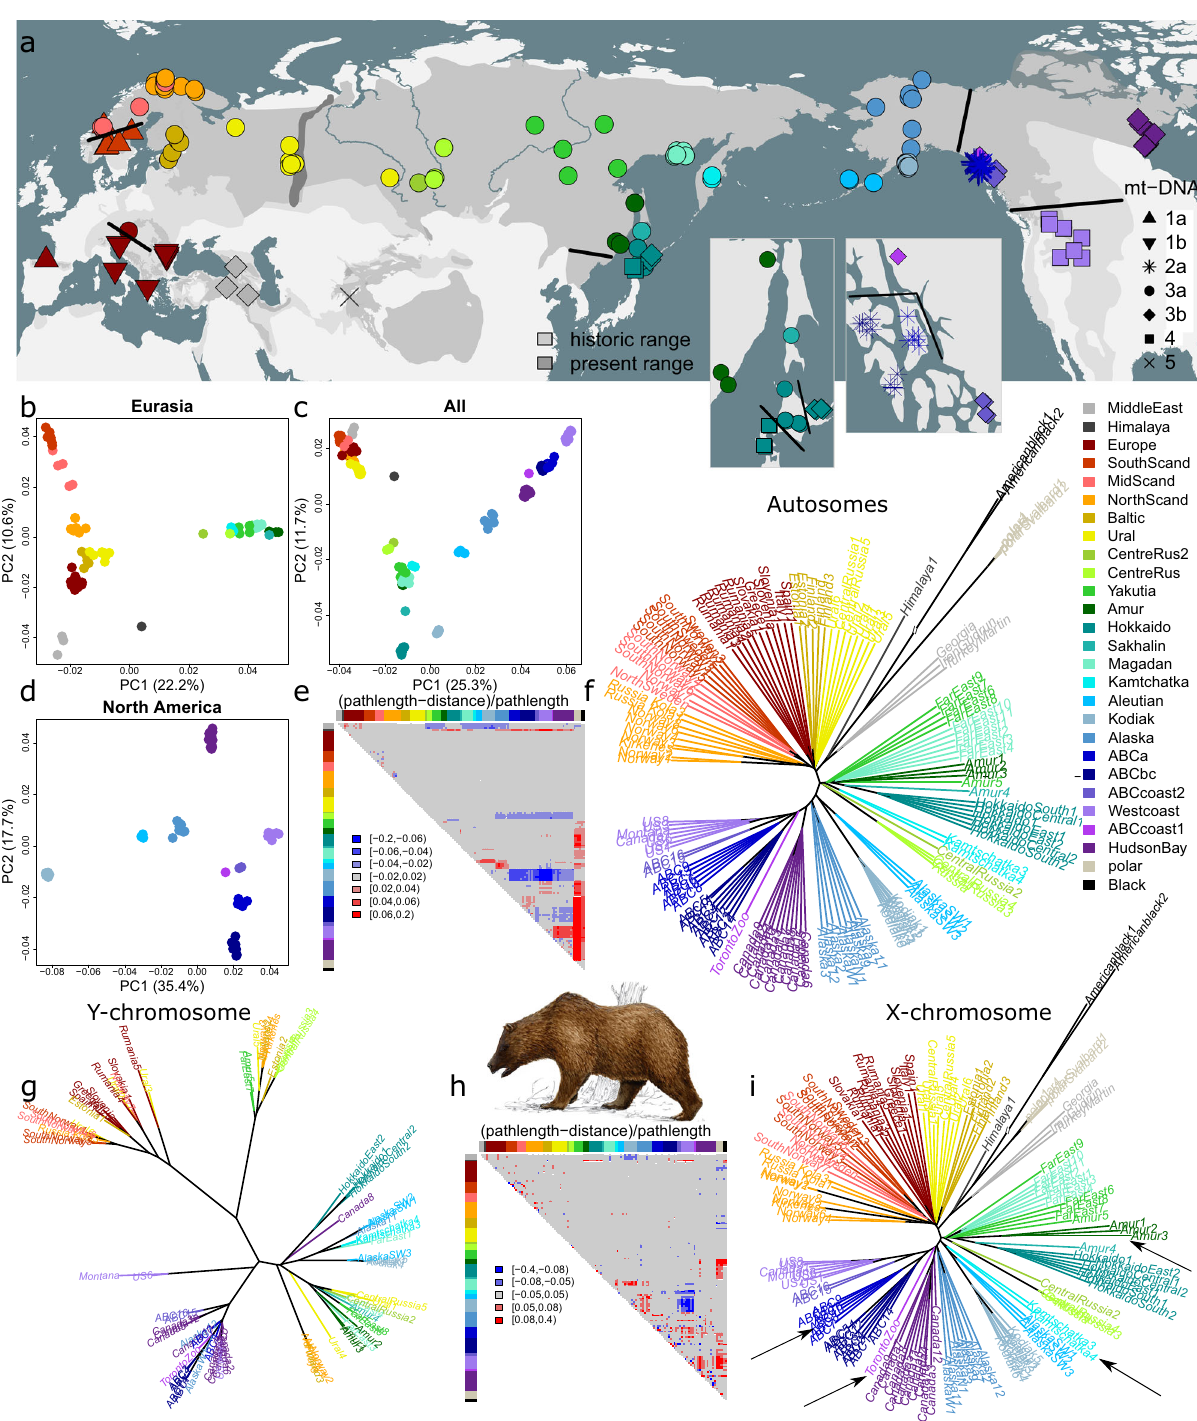
Fig. 1 Brown bear genetic structure: unlike single-locus (mtDNA and Y chromosome) clustering, multi-locus (autosomes and X chromosomes) clustering is largely explained by present-day population connectivity, except for a genomic discontinuity in western Siberia. a Sample distribution. Dark and light grey: present-day and historical geographical range of brown bears (https://www.iucn.redlist.org). Symbol types indicate mtDNA haplotypes. Black lines indicate mtDNA discontinuities. The Ural Mountains (darkgrey shape) and the rivers Ob, Yenisei and Lena (from west to east) are depicted for reference. b – d PCoA-scatterplots based on allele sharing distances calculated from autosomal SNP data. e Residual heatmap for the dendrogram in f, depicting the difference between path lengths in the dendrogram relative to the actual genetic distances in the underlying distance matrix. Red (attraction) indicates that samples are more similar than suggested by the dendrogram, whereas blue (repulsion) indicates the opposite. f Unrooted ‘ biological neighbour-joining ’ (bioNJ) dendrogram (note: not evolutionary phylogeny) based on autosomal allele sharing distances. g Unrooted Y-chromosomal maximum-likelihood phylogeny (generated with the software RAXML), excluding the distant outgroup samples from the Middle East and Himalayas. h Residual heatmap for the dendrogram in i. i Unrooted bioNJ dendrogram depicting X-chromosomal Euclidean genetic distances. Arrows indicate samples or populations which cluster differently or have different branch lengths relative to the autosomal bioNJ dendrogram in